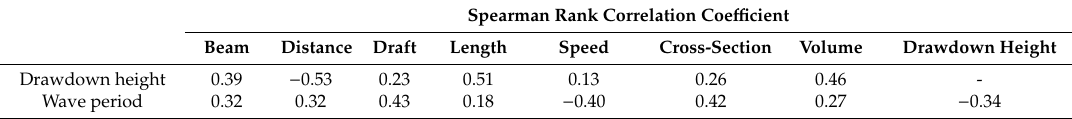
Table 2. Spearman rank correlation coefficient for drawdown wave height and period versus different studied ship parameters.